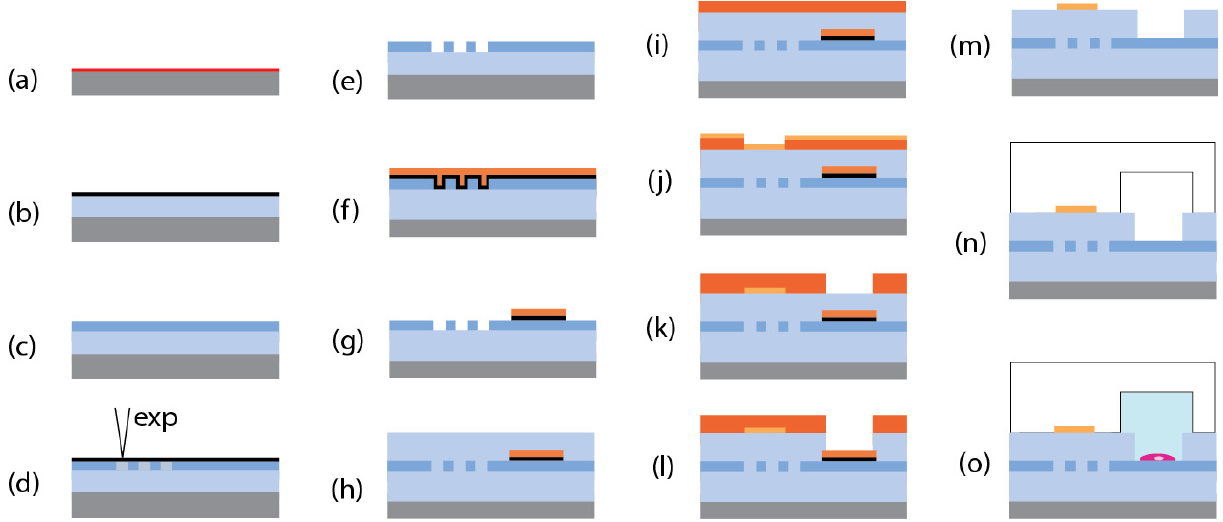
Figure 1. Process flow for fabricating a biophotonic chip with CYTOP waveguide cladding (structures are not to scale). ( a ) Substrate pretreatment; ( b ) CYTOP coating and Al deposition; ( c ) Al removal and coating with waveguide core polymer; ( d ) Patterning of waveguide core polymer by UV or e-beam exposure; ( e ) Development of exposed pattern; ( f ) Deposition of protective layer (if needed) and etch stop photoresist; ( g ) Patterning and development of etch stop layer; ( h ) Coating with top CYTOP cladding; ( i ) Contact layer resist coating; ( j ) Patterning, development, metallization and liftoff; ( k ) Application, patterning and development of etch mask layer; ( l ) Reactive ion etching of sample wells; ( m ) Photoresist and Al protective layer removal; ( n ) APTES treatment and bonding of standard PDMS microfluidic circuits to the CYTOP coated chip; ( o ) Introduction of the (biological)